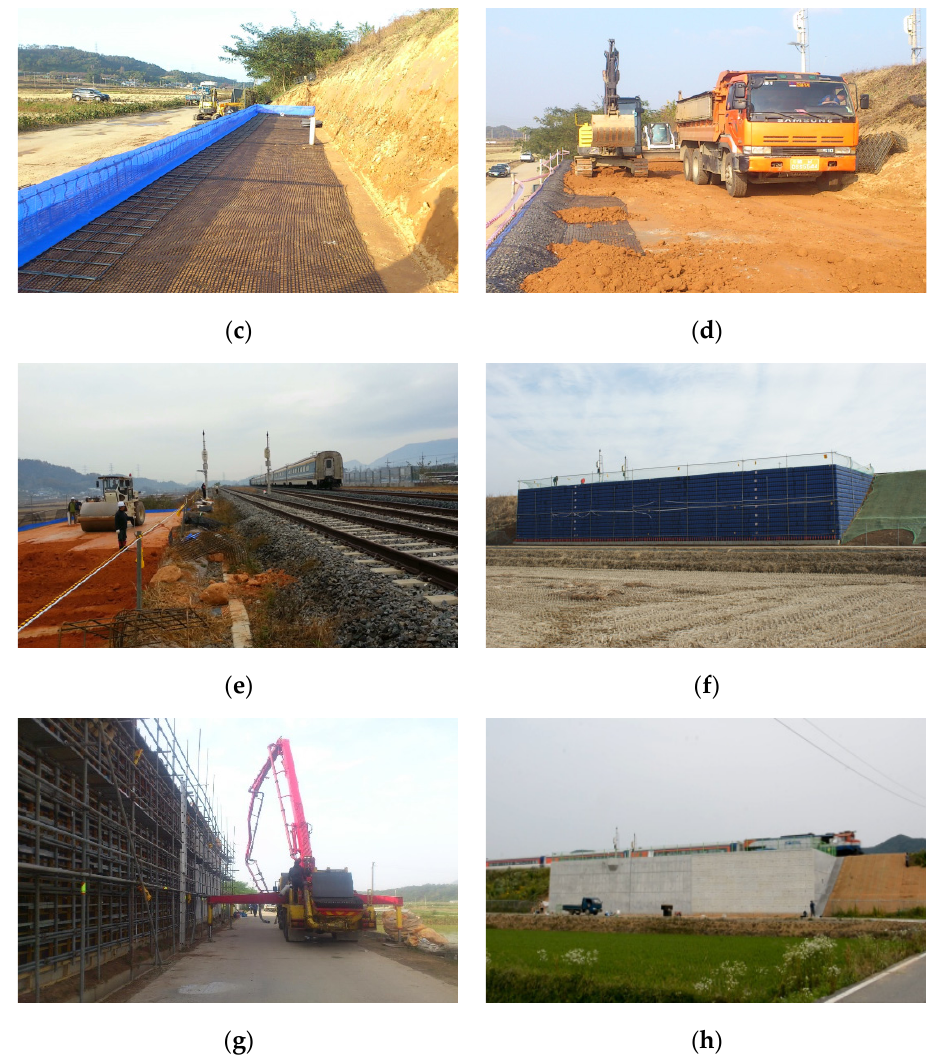
Figure 7. Construction of RSR: ( a ) Excavation and ground replacement; ( b ) Installing the foundation; ( c ) Installing net of welded re-bars and geogrids; ( d ) Placement of the backfill material; ( e ) Compaction; ( f ) Repetition of steps ( c – e ); ( g ) Installing the rigid facing wall; and ( h ) Completion.